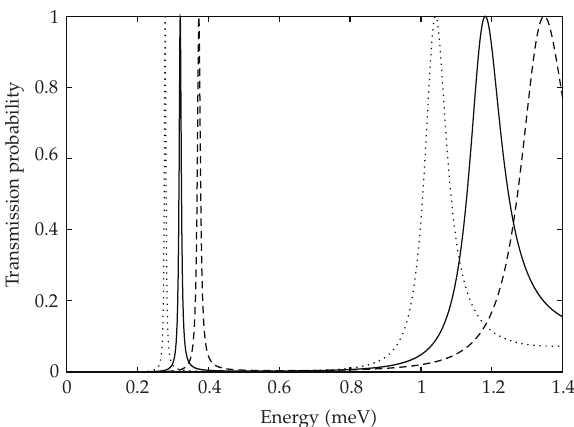
Figure 5: The calculated transmission probabilities for specific incident electron energies on a symmetric rectangular double barrier of height 1.4meV and width 50nm with barrier separations 80nm (cid:9) dashed (cid:10) , 90nm (cid:9) solid (cid:10) , and 100nm (cid:9) dotted (cid:10) . Values were calculated analytically for an isolated ballistic